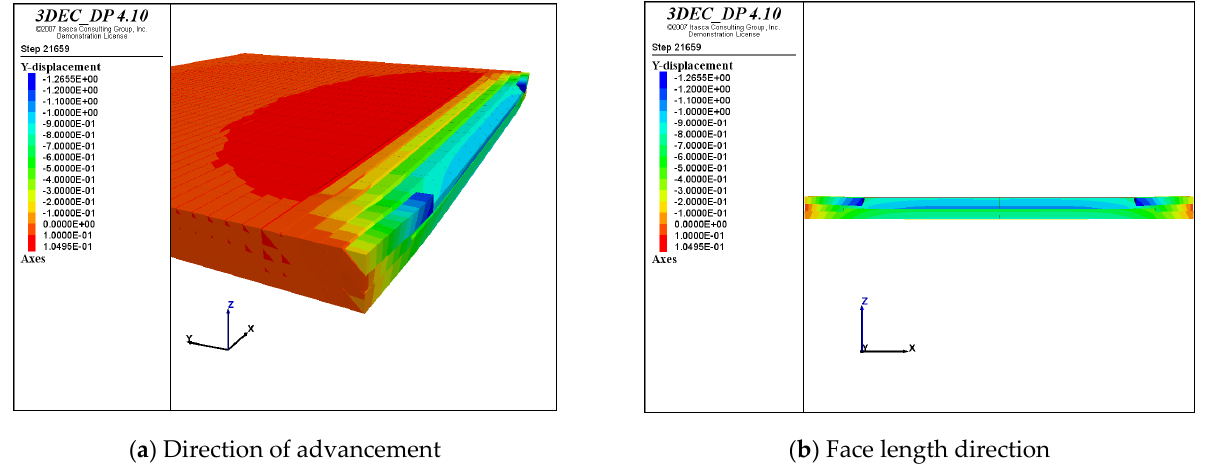
Figure 18. Y-displacement nephogram ( α sj = 45°, d = 1.41 m).